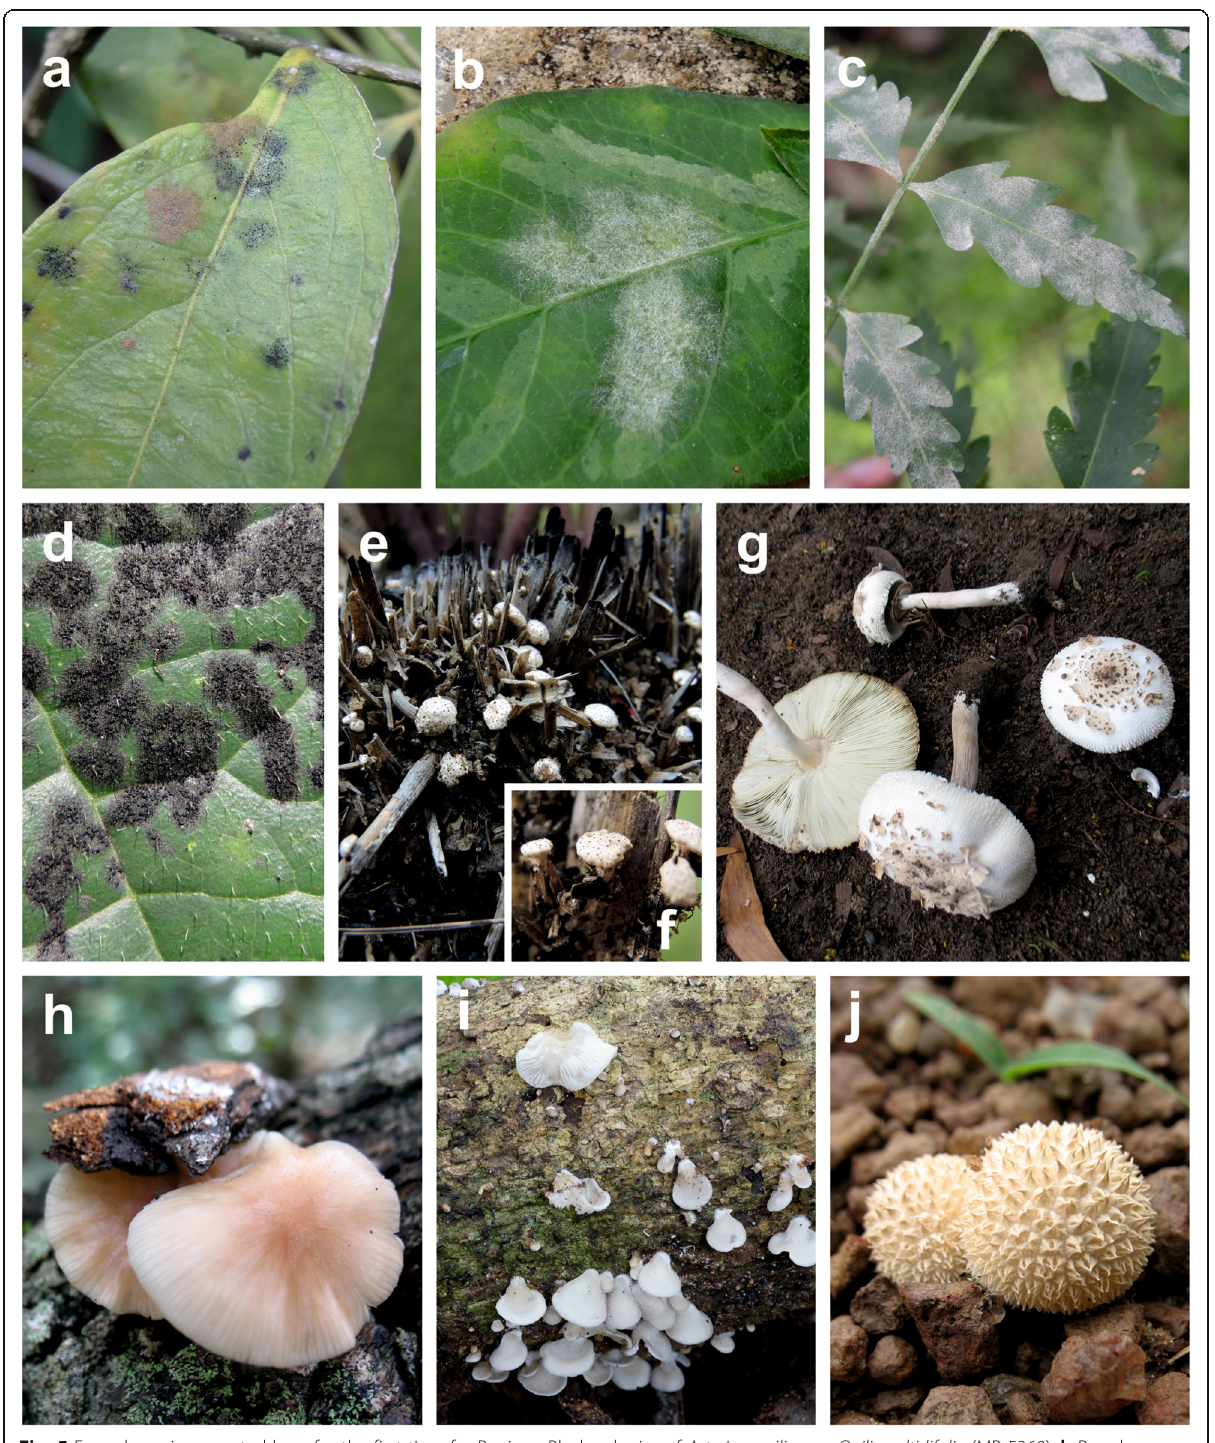
Fig. 5 Fungal species reported here for the first time for Benin. a Black colonies of Asterina opiliae on Opilia celtidifolia (MP 5360). b Powdery mildew caused by Leveillula clavata on Euphorbia heterophylla (B 16). c Powdery mildew caused by Pseudoidium azadirachtae on Azadirachta indica (MP 5377). d Black mildew caused by Meliola clerodendricola on Clerodendrum capitatum (MP 5371). e – f Podosordaria ustorum (Taneka 25.7.2017, no specimen). e Spore-producing bodies on a burnt tussock of Andropogon tectorum . f Individual spore-producing bodies with stipes attached to dead grass. g Chlorophyllum globosum (KaiR111). h. Gymnopus gibbosus (KaiR72). i Hohenbuehelia aff. grisea (KaiR770). j Lycoperdon endotephrum